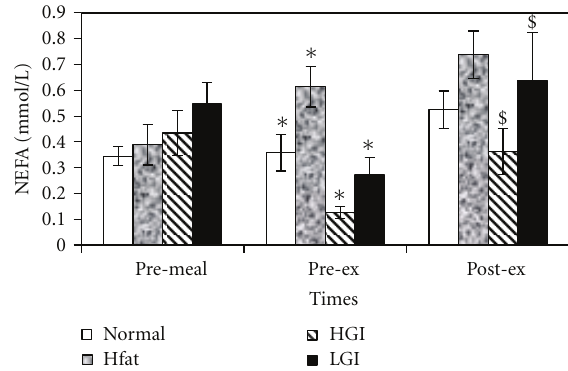
Figure 1: Mean ( ± SE) plasma NEFA concentrations at pre-meal, pre-exercise, and post-exercise for four trials. ∗ indicates significant with resting values and $ indicates significant di ff erence with postprandial values.